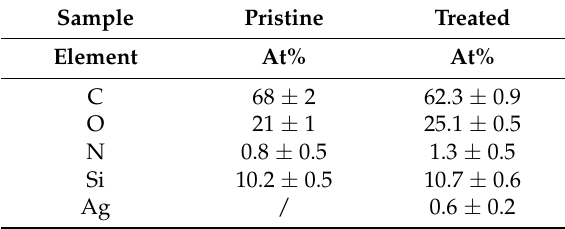
Table 3. Elements typical of polyurethane-based materials were identified, as well as significant amounts of silicon. Surface percentages showed, also on these samples, excellent point-to-point reproducibility. Table 3. Surface elemental composition estimated by XPS of leatherette samples treated with 4% w / w Ag precursor. Error is expressed as the larger value between the error associated to a single quantification (0.2% for silver, 0.5% for other elements) and one standard deviation, calculated on at least three replicate analyses. Data on pristine samples are reported for comparison.